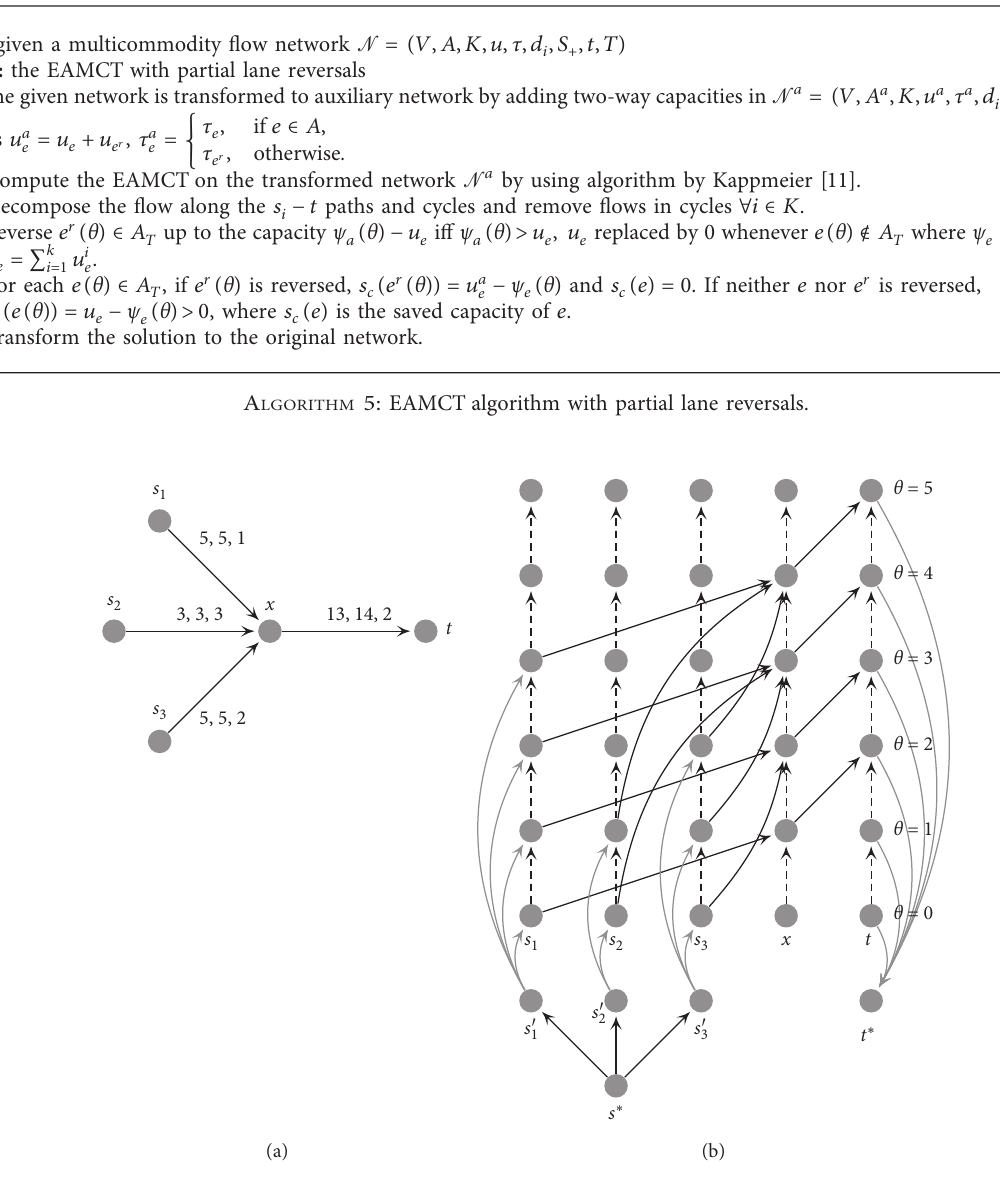
Figure 7: (a) Network having flow, capacity, and transit time on the arc after lane reversals. (b) Time-expanded network of